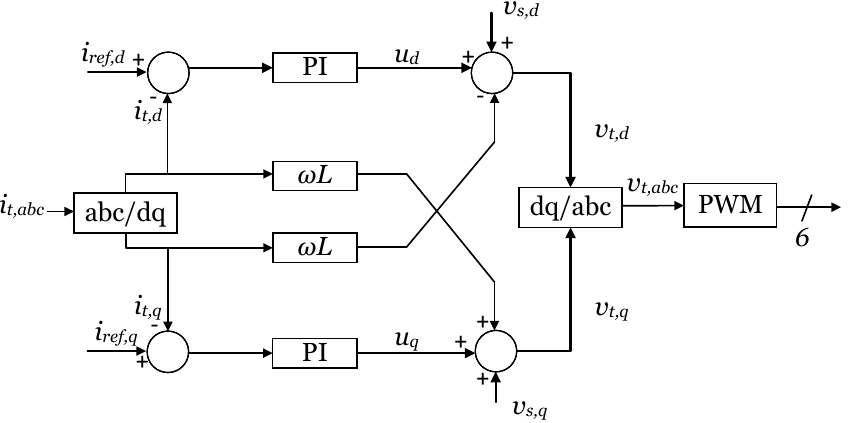
Figure 2. Conventional dq current control